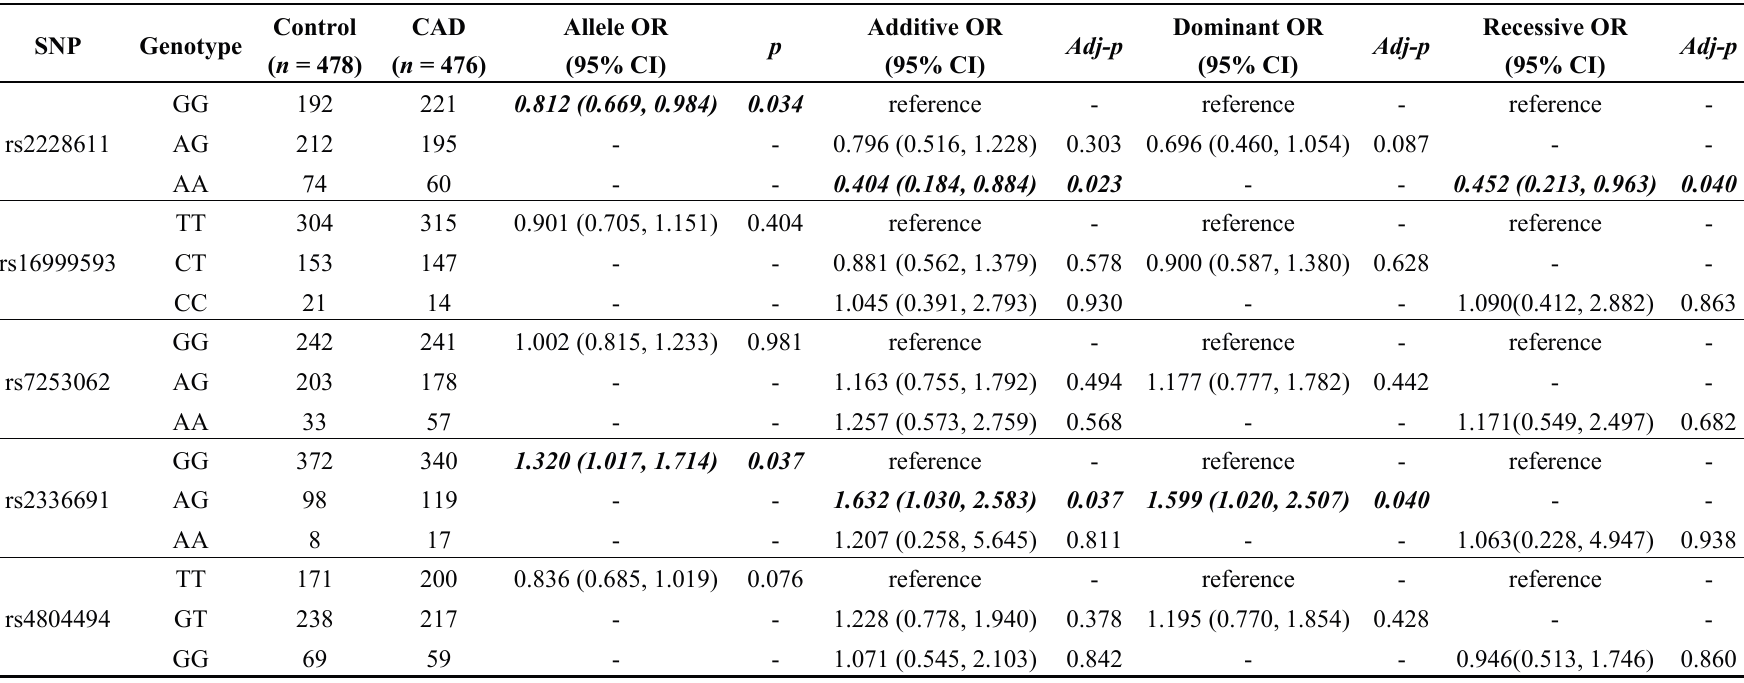
Table 3. Risk estimated based on the distributions of genotype and allele